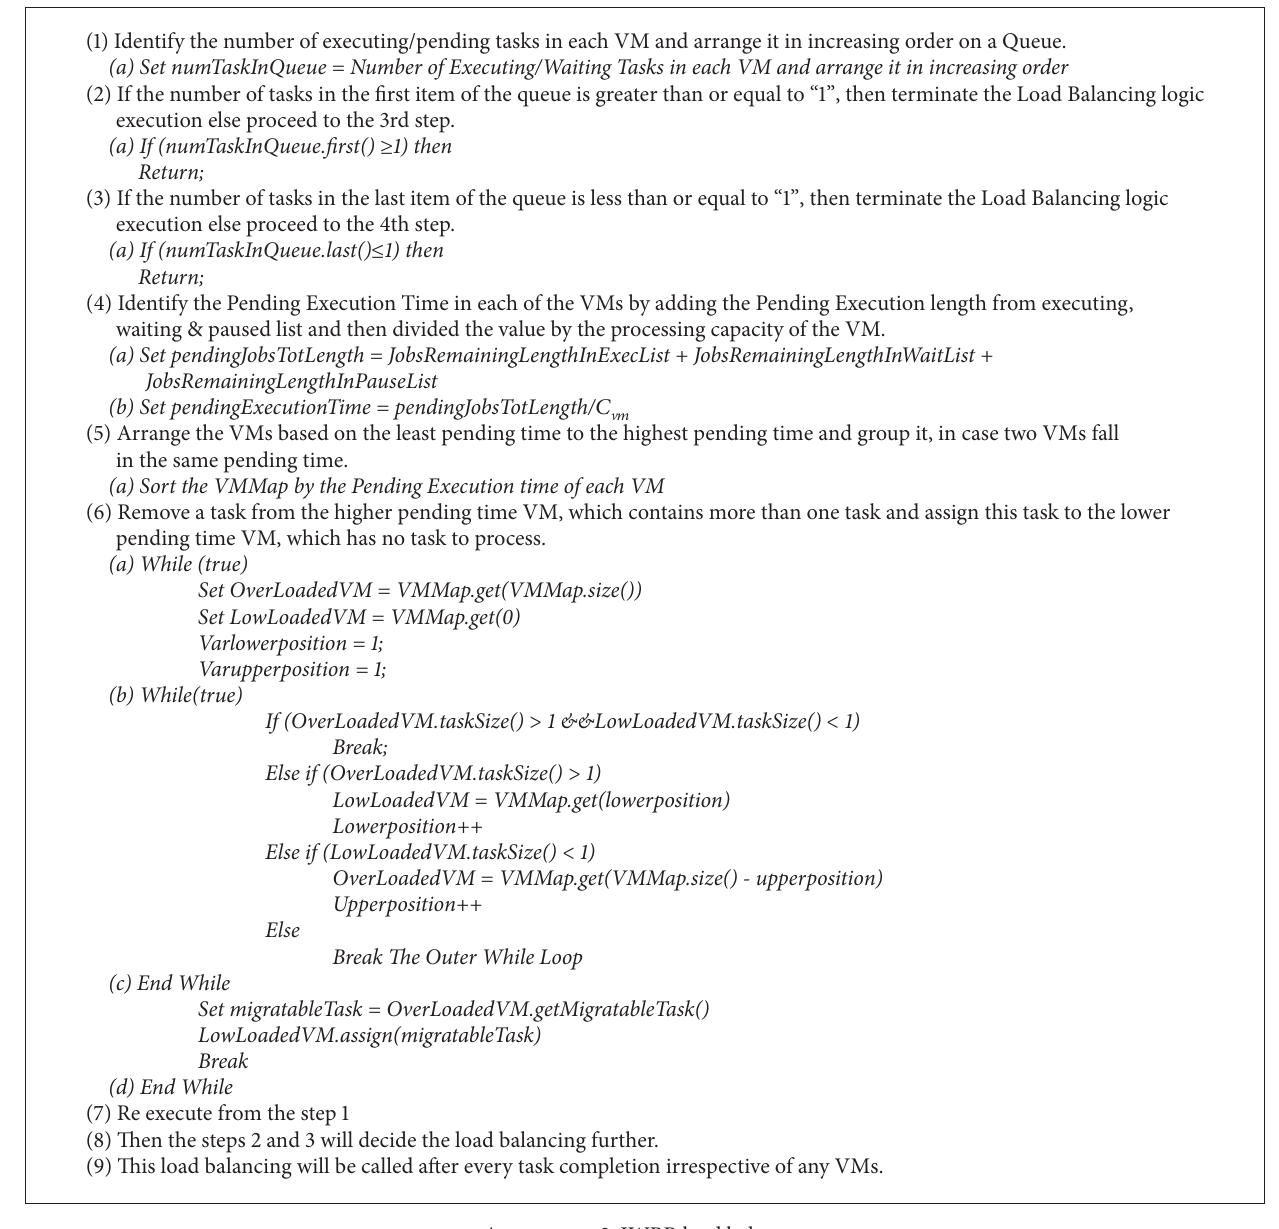
Algorithm 2: IWRR load